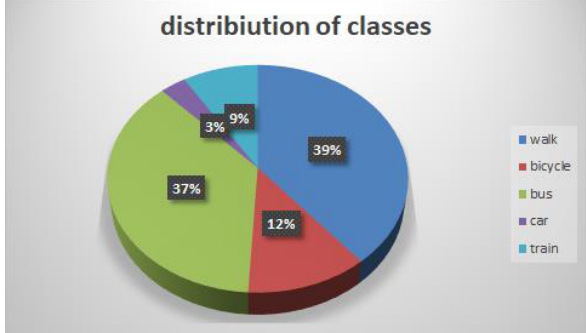
Figure 6. A pie diagram of class distribution in the Geolife dataset after removing noise and extracting features